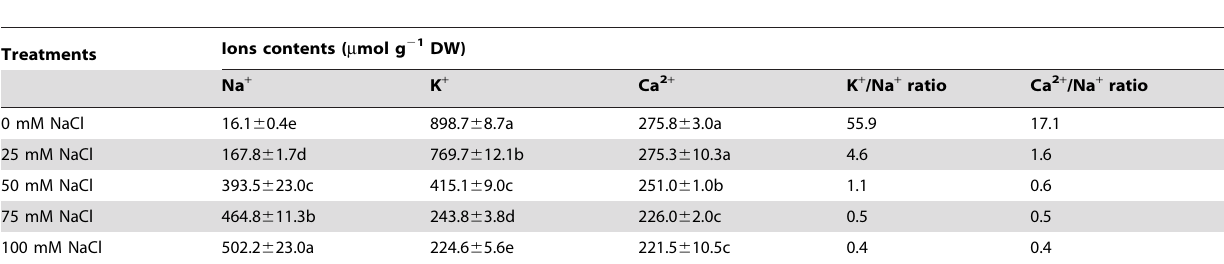
Table 2. The effects of various NaCl concentrations on the ion content and selective absorption of Salvia miltiorrhiza seedlings.